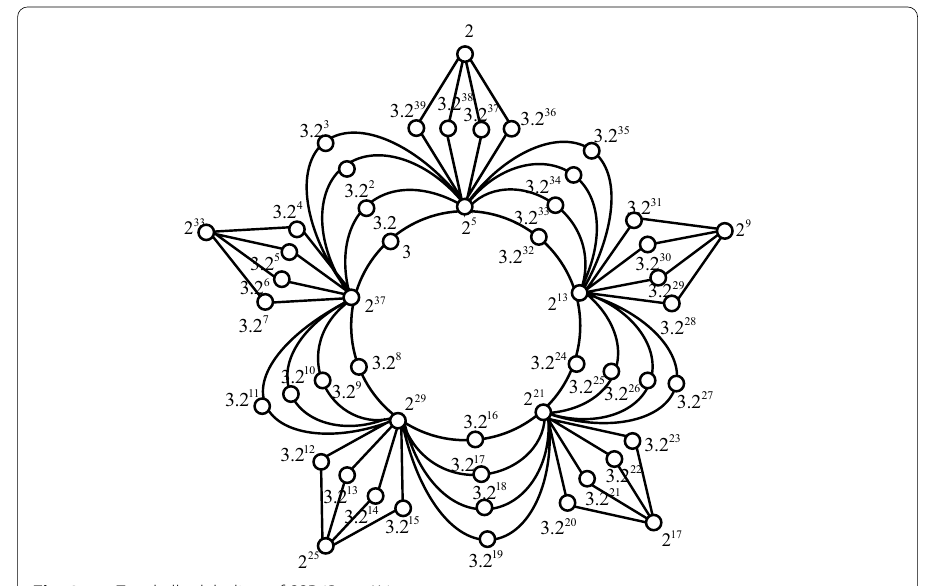
Fig. 3 15-Zumkeller labeling of SSD ( P 5 ⊙ K 1